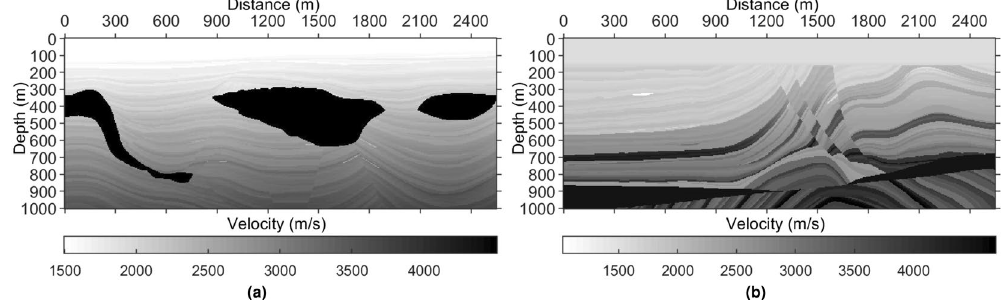
Figure 3. Velocity models used to generate the synthetic data. Each velocity model has its own density model. ( a ) Adapted Pluto 1.5 model. ( b ) Down-sampled Marmousi2 model. The lateral spacing dx and the depth spacing dz are 5